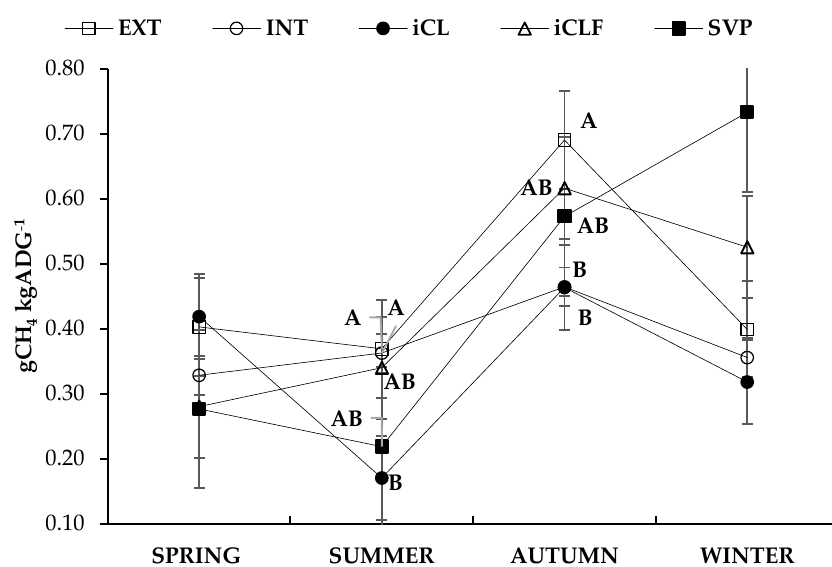
Figure A9. Enteric methane emission (kg) per kilogram of ADG during seasons from different livestock production systems (means of two years). Different letters in the same season differ from each other ( p < 0.05) according to the Tukey test. EXT: extensive; INT: intensive; iCL: integrated crop–livestock; iCLF: integrated crop–livestock–forest; iLF: integrated livestock–forest.